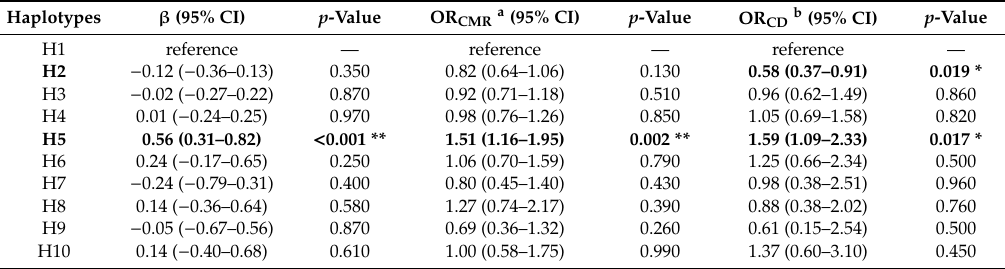
Table 6. The e ff ect of haplotypes in CETP gene on triglycerides to HDL-C ratio (TG / HDL-C ratio) in combined population (Hungarian Roma and Hungarian general together). The association was evaluated under adjusted models (ethnicity, sex, age, body mass index, systolic and diastolic blood pressure, fasting glucose level, antihypertensive, antidiabetic and lipid-lowering treatment).